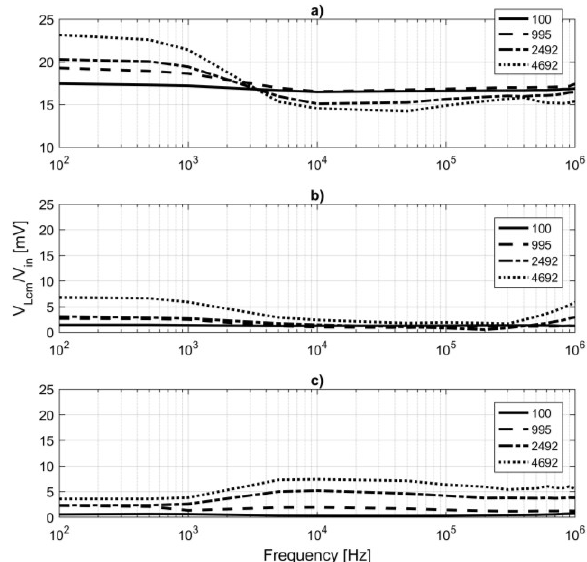
Fig.26: Measured load common mode voltage. a) QUAD b) DIF_C c) DIF_M